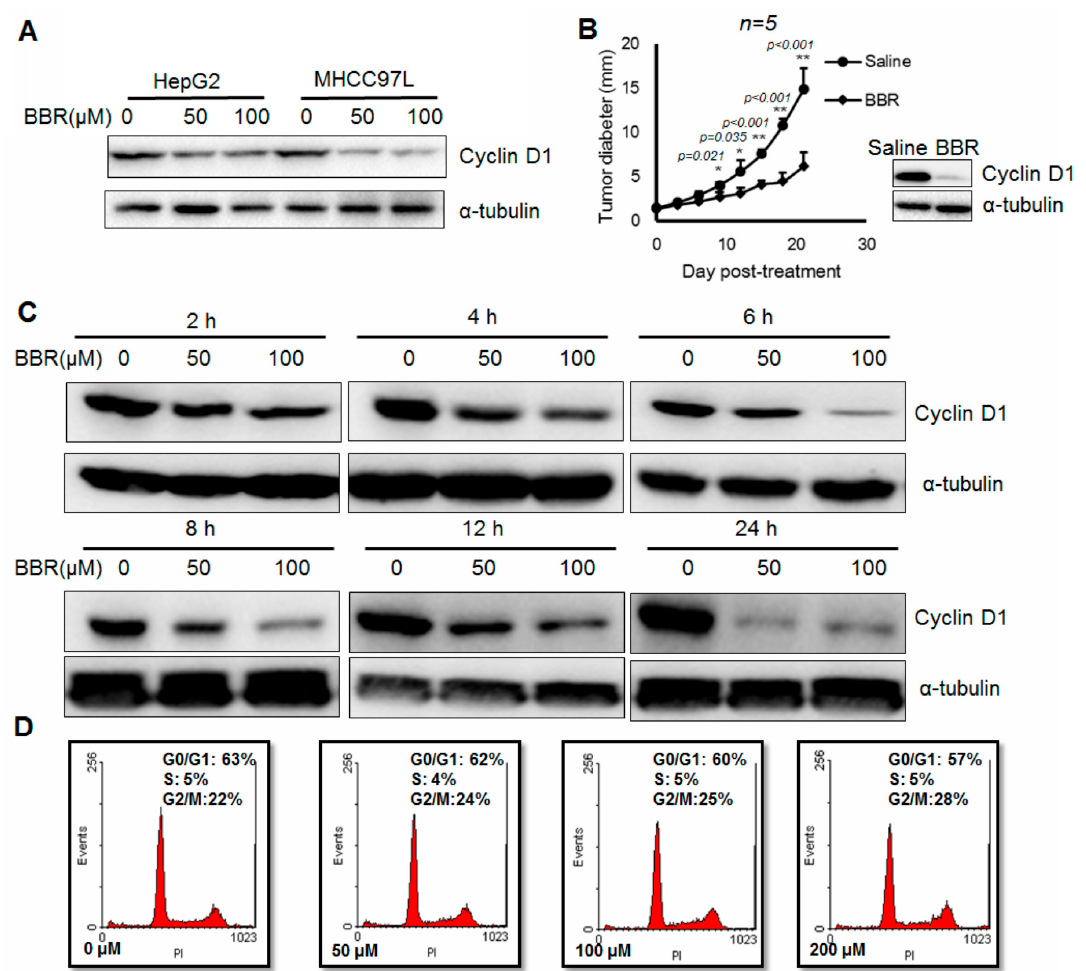
Figure 1. Berberine suppresses Cyclin D1 expression in hepatoma cells. ( A ) HepG2 and MHCC97L cells were treated with 100 µM berberine for 24 h. the expression of Cyclin D1 was inhibited; ( B ) Xenograft model was established as described and treatment of berberine can lead to reduced tumor size as well as Cyclin D1 expression; ( C ) Upon 6 h exposure of 100 µM berberine, the expression of Cyclin D1 was potently repressed. Cyclin D1 was detected by immunoblotting with β -actin as internal control; ( D ) HepG2 cells were treated with berberine at different doses for 6 h and then subject to cell cycle analysis. No significant cell cycle phase redistribution was observed. * p < 0.05,** p < 0.01.